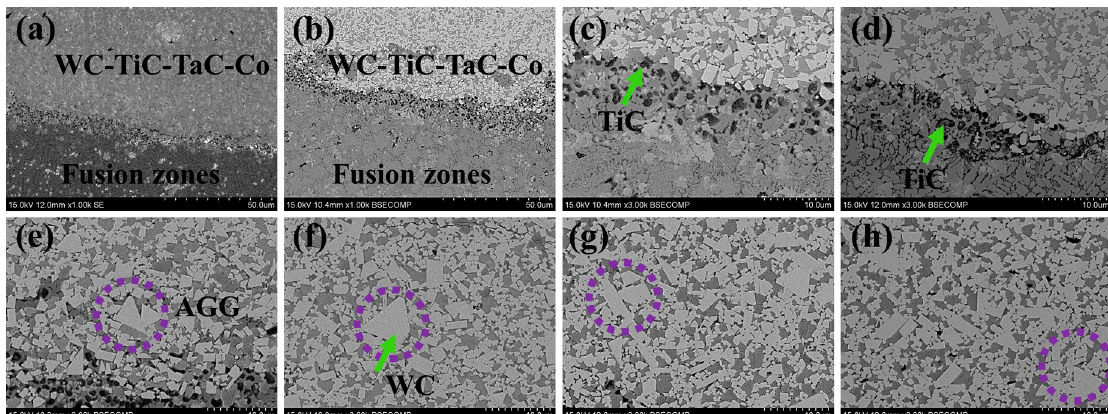
Figure 4. Laser welding of super-fine cemented carbide (WC–TiC–TaC–Co) and stainless steel without filler metals. ( a ) Second electron (SE) micrograph and back-scattered electron (BSE) micrographs ( b , c ) at low magnification and ( d ) high magnification showing the WC–TiC–TaC–Co / 316L stainless steel interface. ( e – h ) Normal grain growth and abnormal grain growth (AGG) of WC grains near the interface.